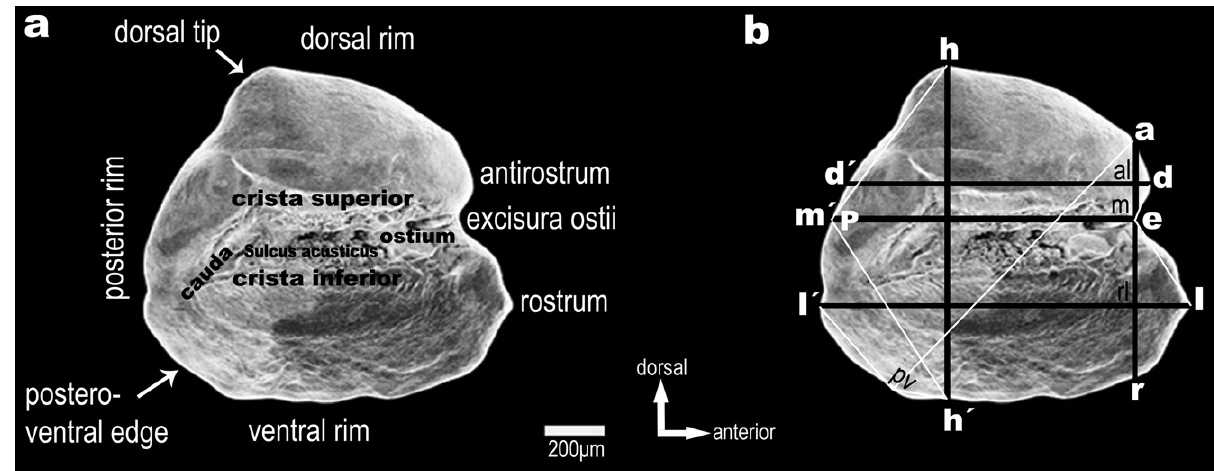
Fig . 1. – Otolith morphology (a) and morphometry (b) of Aphanius dispar from a coastal lagoon near Sib, Oman (site 2); otolith is shown in medial view. Terminology of otolith characters follows Nolf (1985); linear measurements and angles after Reichenbacher et al. (2007). l-l´ length, h-h´ height, m-a antirostrum height, m-r rostrum height, rl-l rostrum length, al–d antirostrum length, m-m´ medial length, d-d´ dorsal length, e excisura angle, p posterior angle, pv posteroventral